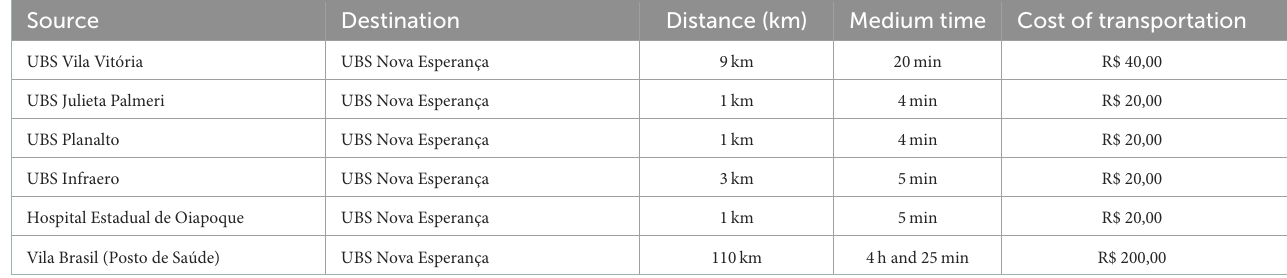
TABLE 1 Detailed flows of the shortest route by car (time and distance) between the health units that performed the testing and the health units responsible for the treatment.